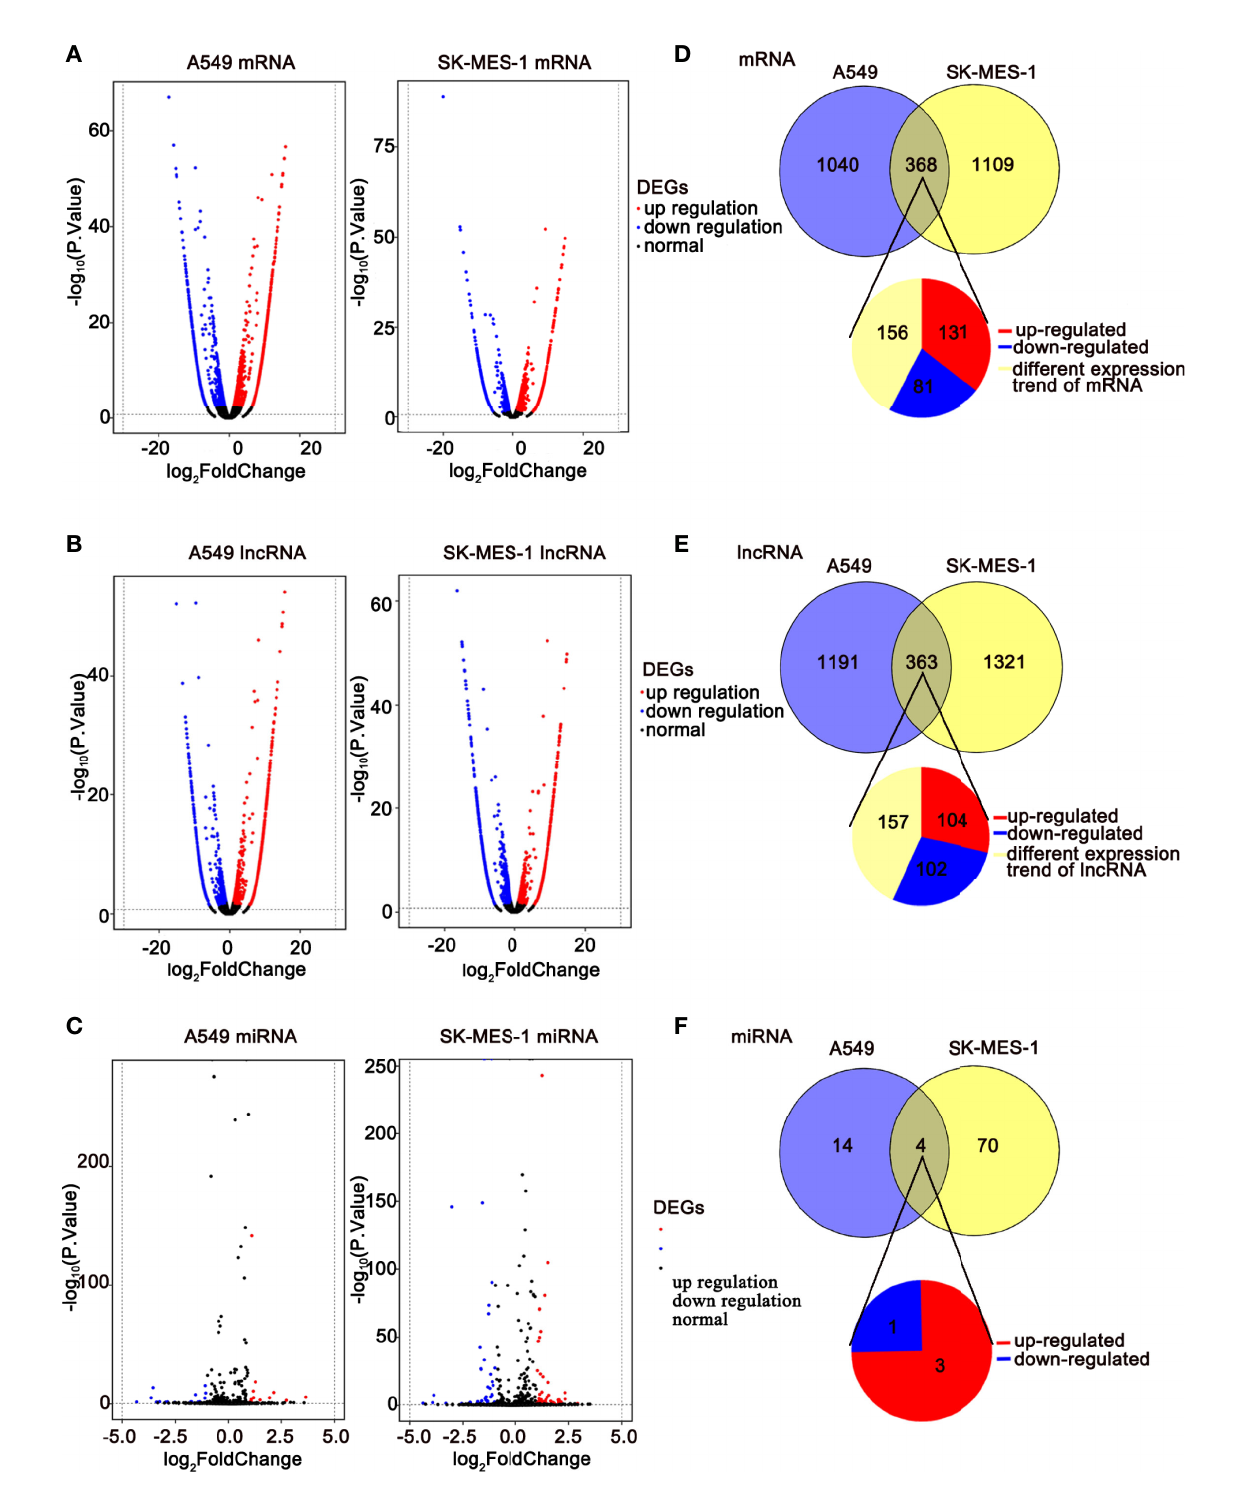
FIGURE 6 | RNA-seq revealing distinct expression patterns of miRNAs, lncRNAs, and mRNAs in control of NSCLC cells and ivosidenib-treated NSCLC cells. (A – C) Volcano plot of DE-mRNAs, DE-lncRNAs, and DE-miRNA expression pro fi les between control NSCLC cells and ivosidenib-treated NSCLC cells. (D – F) Venn diagram showing the overlap number of DE-mRNA, DE-lncRNA, and